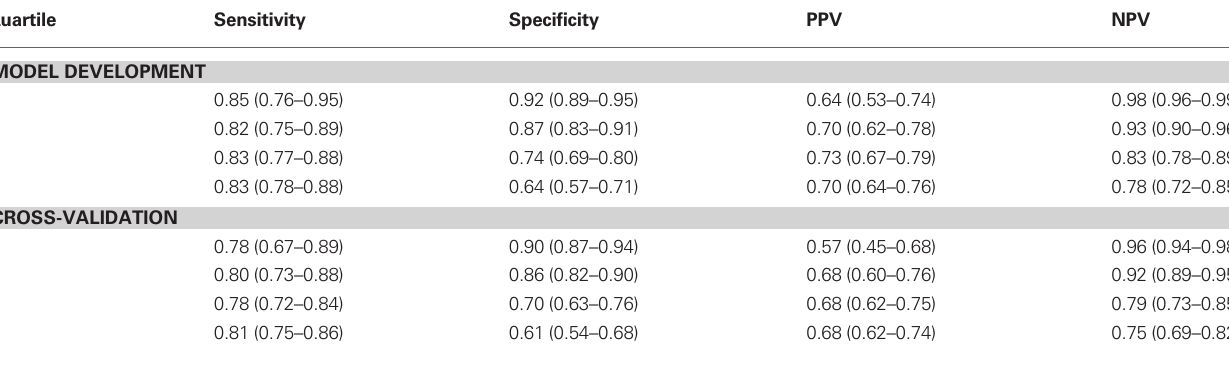
Table 3 | Sensitivity, specificity, positive predictive value (PPV), and negative predictive value (NPV) with 95% confidence intervals of the eeg-based present performance model after grouping the observed and estimated F -Measure into classes of unacceptable ( F -Measure < 0.80) and acceptable ( F -Measure ≥ 0.80) performance.